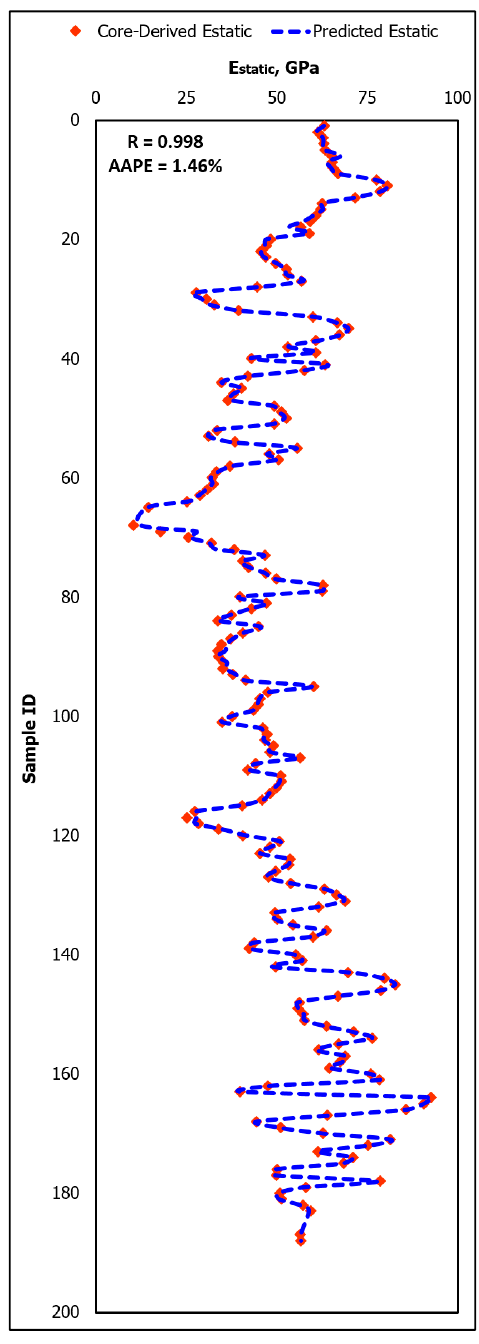
Figure 5. Predicted and core-derived E static of the testing data, Well-A.